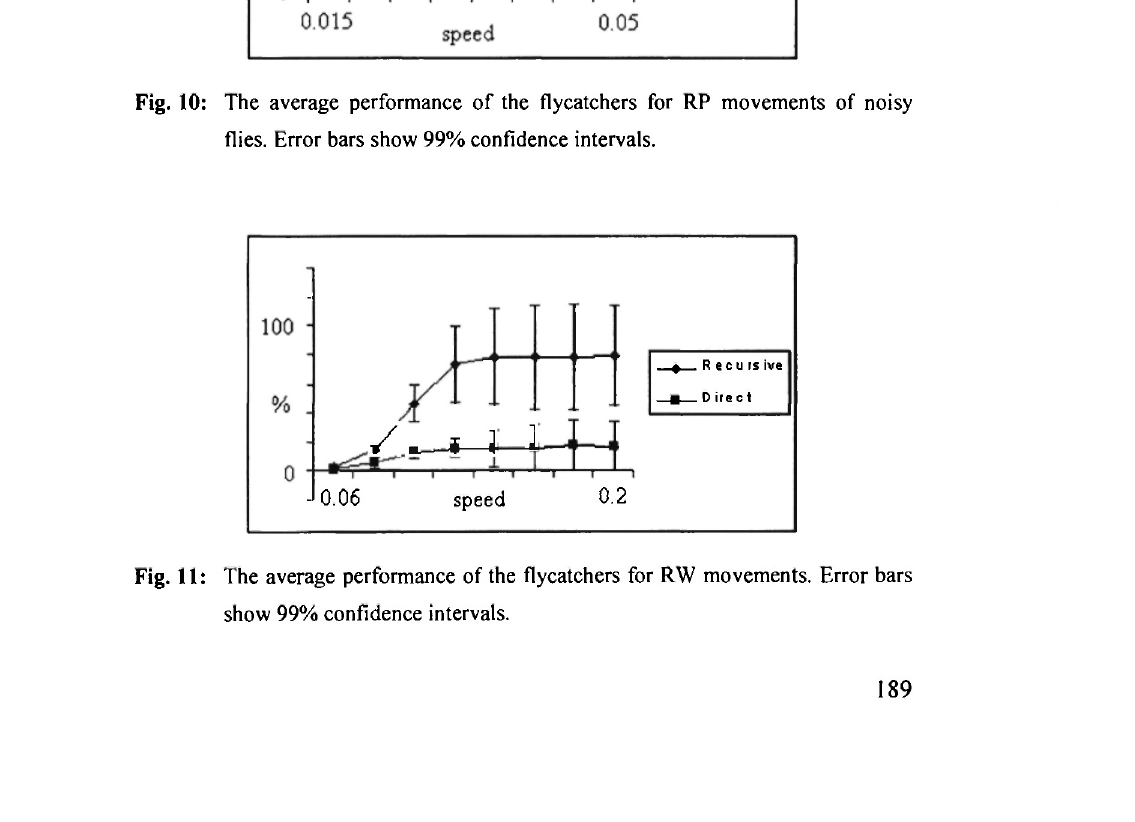
Fig. 10: The average performance of the flycatchers for RP movements of noisy flies. Error bars show 99% confidence intervals.